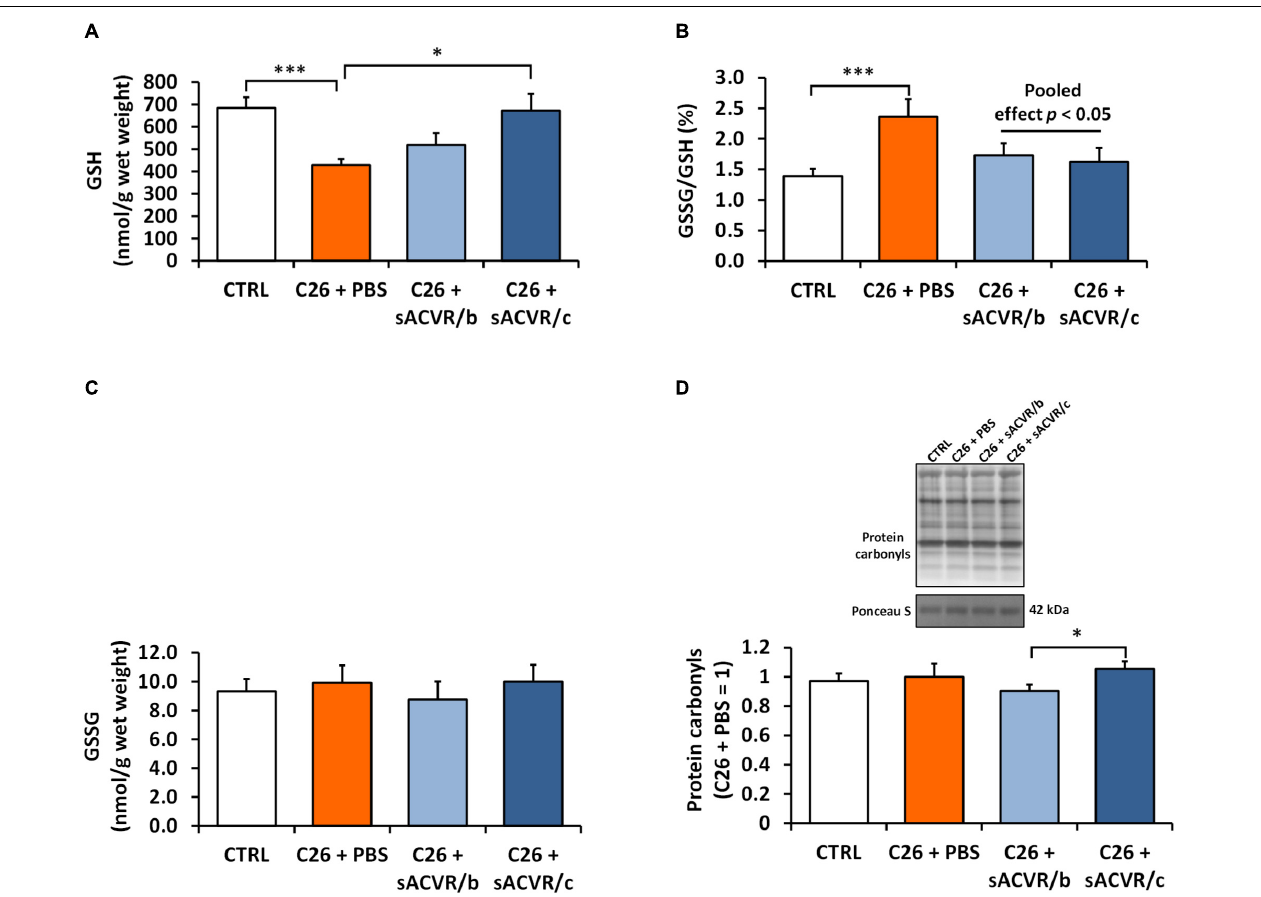
FIGURE 5 | Redox balance markers in skeletal muscle of C26 tumor-bearing mice. (A) Reduced glutathione (GSH), (B) ratio of oxidized to reduced glutathione (GSSG/GSH), (C) oxidized glutathione (GSSG), and (D) protein carbonyls. CTRL, vehicle-treated (PBS) healthy control mice, n = 7–9. C26 + PBS = C26 tumor-bearing mice administered with a vehicle (PBS), n = 7. C26 + sACVR/b = C26 tumor-bearing mice administered with sACVR before the tumor formation and replaced by a vehicle (PBS) after the tumor formation, n = 7. C26 + sACVR/c = C26 tumor-bearing mice continuously administered with sACVR throughout the experiment, n = 8. The symbol ∗ depicts statistical significance p < 0.05 whereas the symbol ∗∗∗ depicts statistical significance p < 0.001. For the pooled effect sACVR administered groups were pooled. Data is expressed as means ± SE. Protein carbonyls were normalized to Ponceau S staining (strongest band at ∼ 42 kDa). Representative protein carbonyl blot was cropped from the original blot image ( Supplementary Figure 10